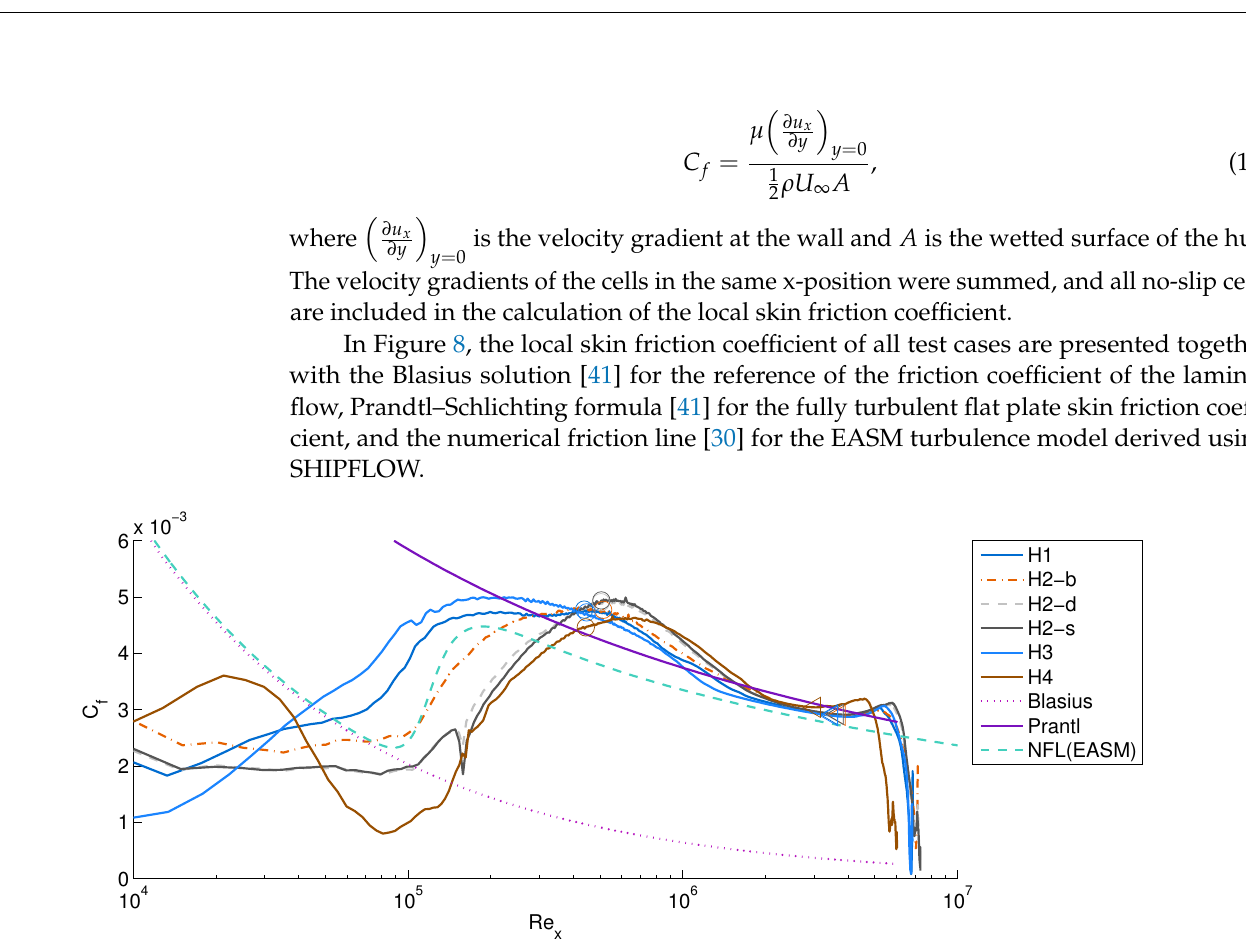
Figure 8. Local skin friction resistance coefficients for all hulls versus Reynolds